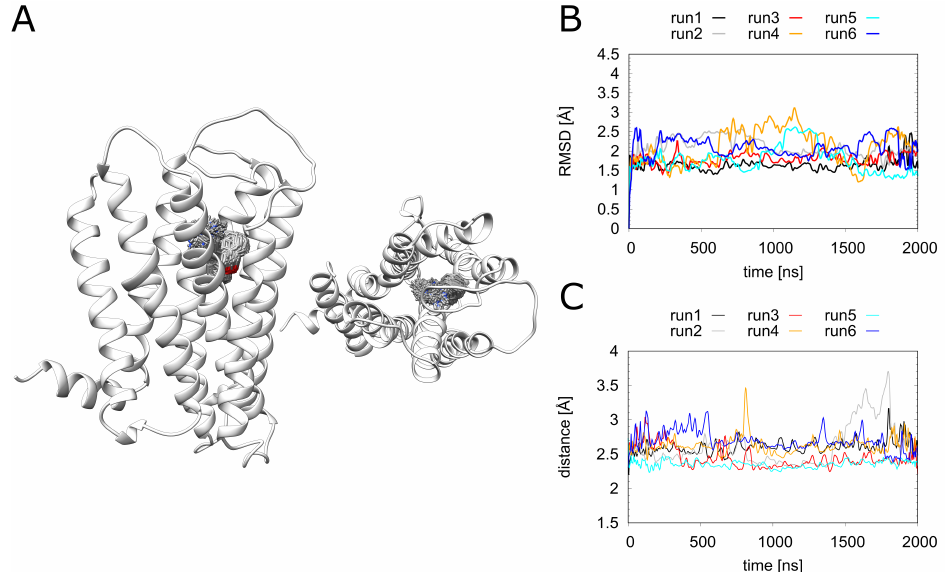
Figure 6. Doxepin interactions. ( A ) H 1 R structure (white ribbon) depicting the doxepin position derived from simulation at time intervals of 1 ns. Doxepin is shown as gray sticks with oxygen in red and nitrogen in blue. ( B ) The ligand RMSD and ( C ) minimum doxepin-D107 2.50 distance over the